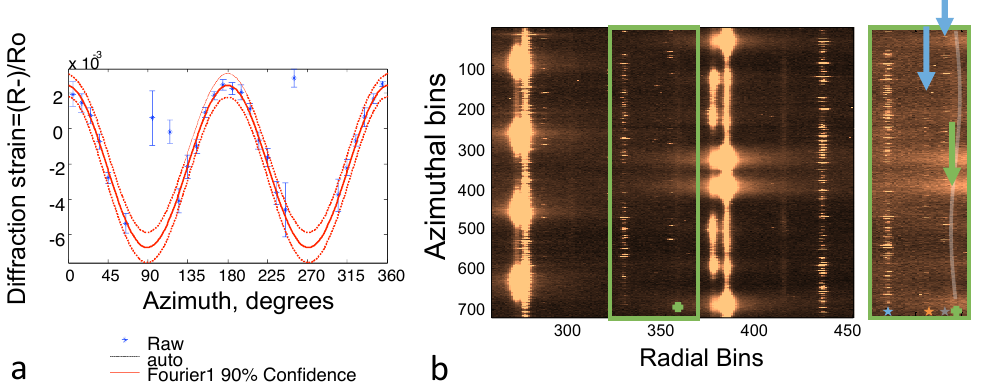
Figure A2. Strain analysis and fitting challenges for transformed Debye rings: ( a ) fitting challenges for strain response with bond coat overlap over alumina peak, with representations of in plane (e22) and out of plane (e11) strain data; and ( b ) examination of transformed Debye rings with precipitates obscuring oxide layer ring. Secondary peaks marked in blue interfere with faint TGO peak marked in